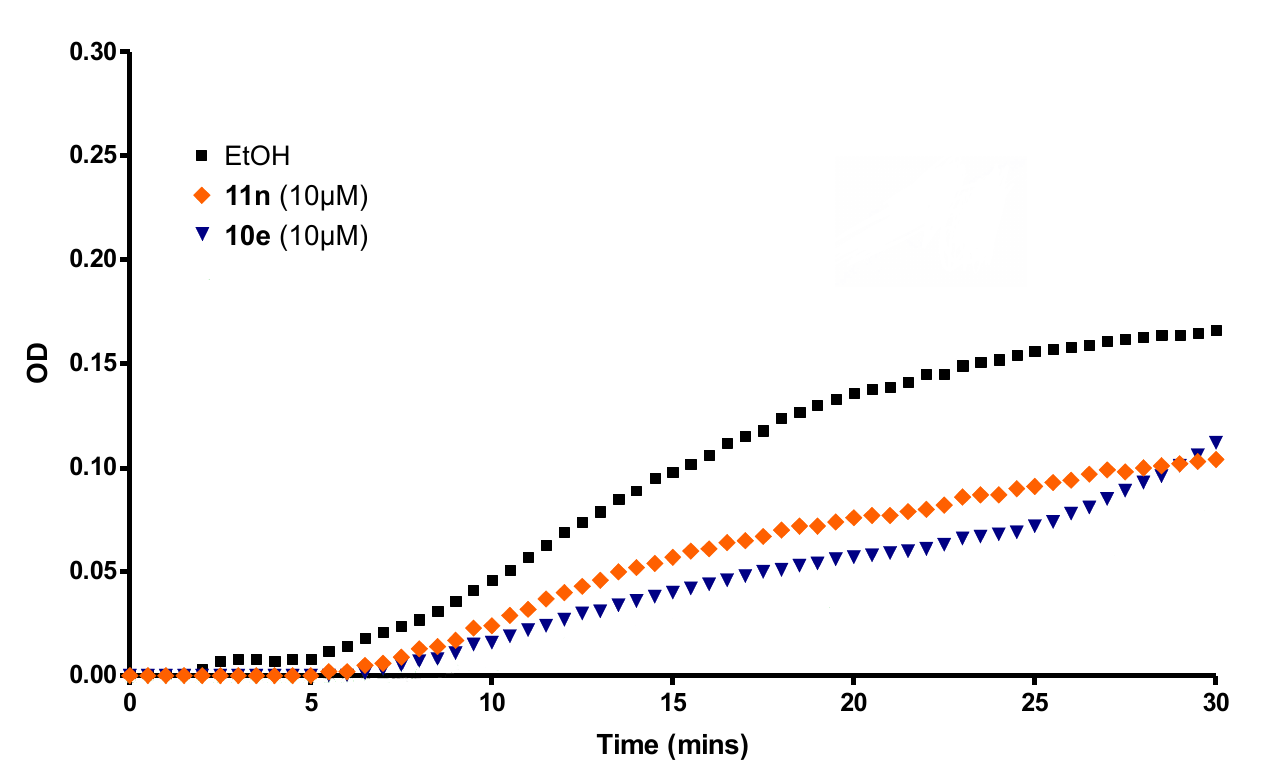
Figure 7. Tubulin polymerisation assay for compounds 10e and 11n . Compounds 10e and 11n induce depolymerisation of tubulin in vitro. Effect of compounds 10e and 11n on in vitro tubulin polymerisation: compounds 10e and 11n (10 µ M concentration) were first mixed with purified bovine tubulin in a 96-well plate on ice. Purified bovine tubulin and GTP were mixed in a 96-well plate at 37 ◦ C. Ethanol (1% v / v ) was used as a vehicle control. The final concentration of bovine tubulin was 3 mg/mL and glycerol was 10%. After placing the plate into a 37 ◦ C incubator, the effect on tubulin assembly (OD—optical density) was monitored in a Spectramax 340 PC spectrophotometer for 30 min at 37 ◦ C and 340 nm in 30 s intervals. Percentage inhibition of polymerisation was recorded for each reaction. The results represent the mean for three separate experiments performed in duplicate. Table 8. Inhibition of tubulin polymerisation for compounds 10e , 11n and CA-4 and their corre-